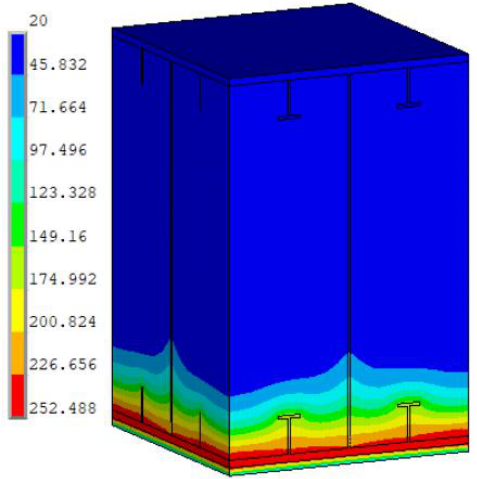
Figure 22. Time-temperature curves of each measuring point in the member without fire prevention measures.